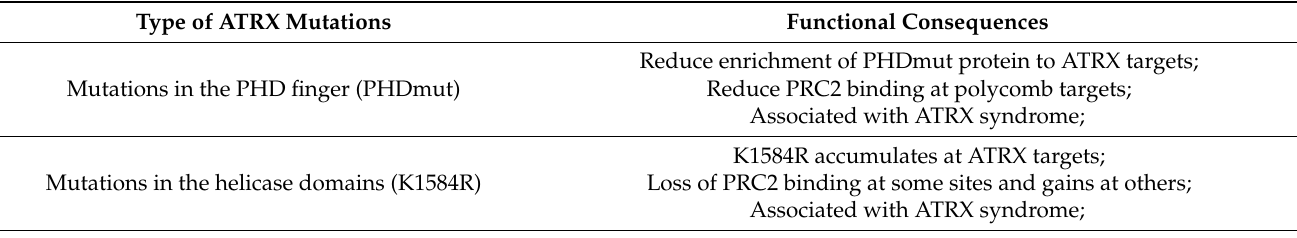
Table 1. Type of ATRX mutations and their functional consequences. Type of ATRX Mutations Functional